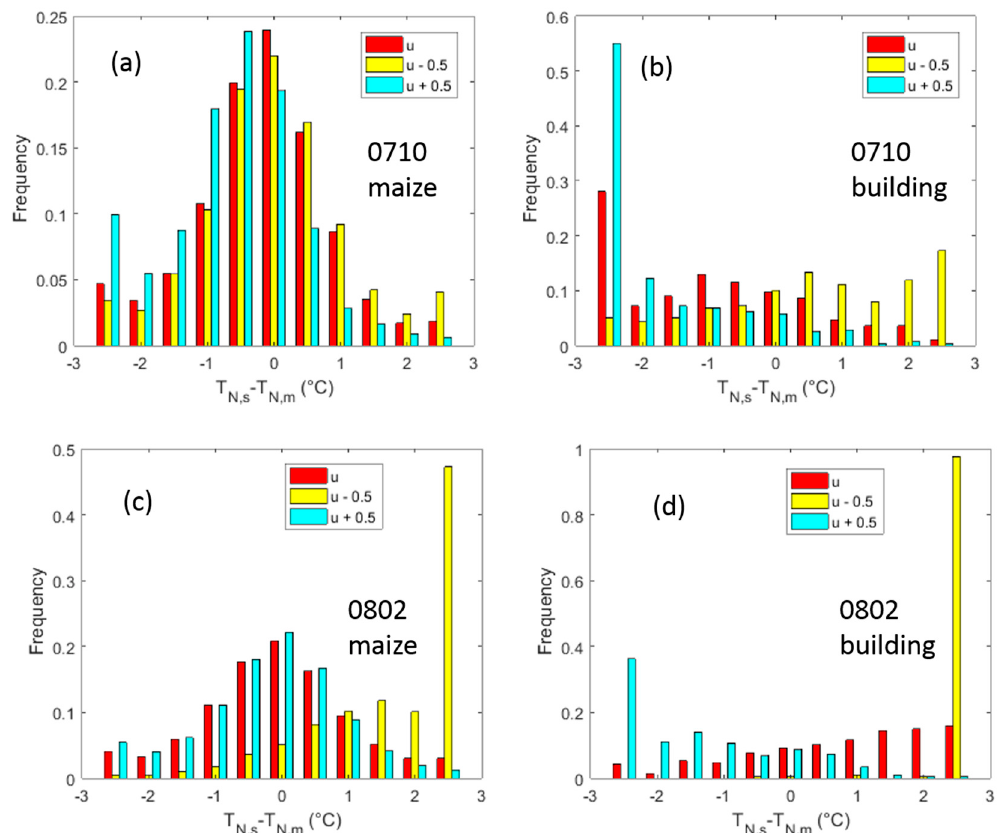
Figure 8. Histograms of the differences in temperature between the simulated and observed values with different wind speed errors on ( a , b ) 10 July 2012 and ( c , d ) 2 August 2012. ( a , c ) refer to vegetation pixels, and ( b , d ) refer to building pixels.